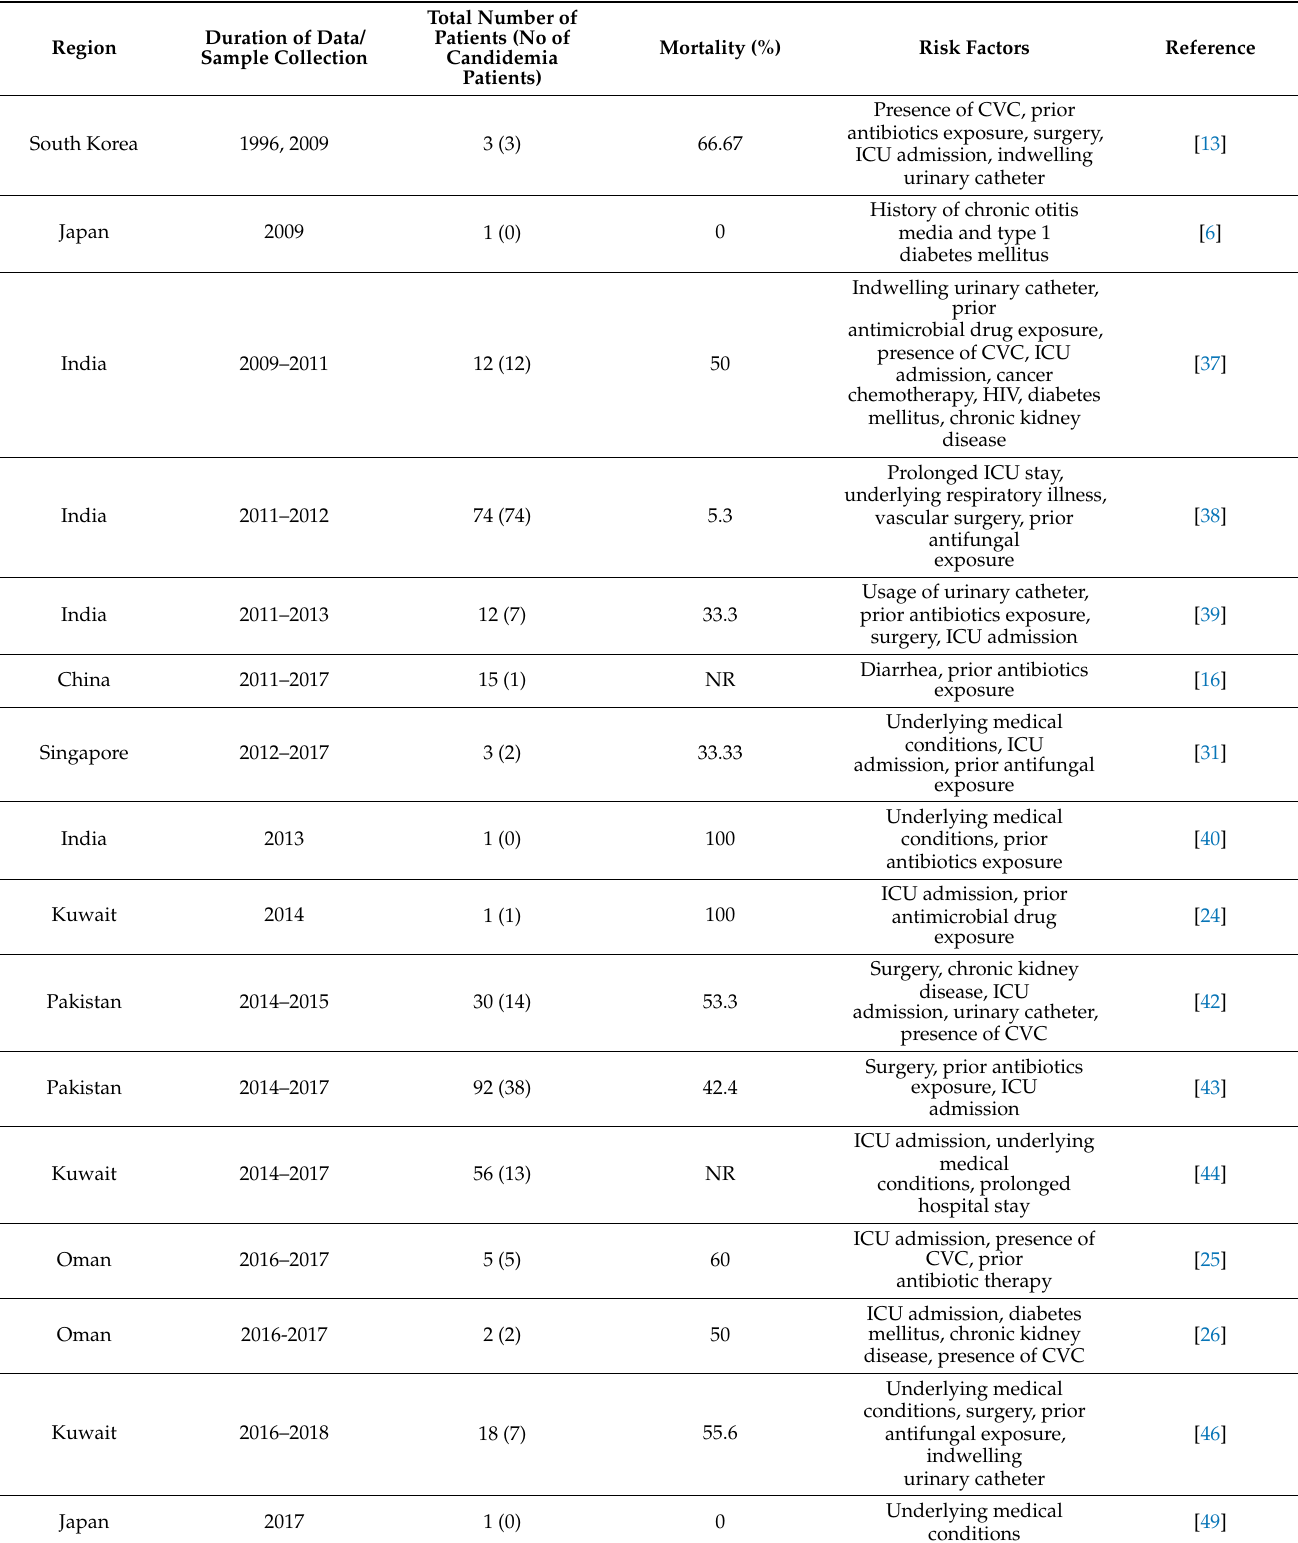
Table 2. List of risk factors of C. auris infections based on some published studies from Asia